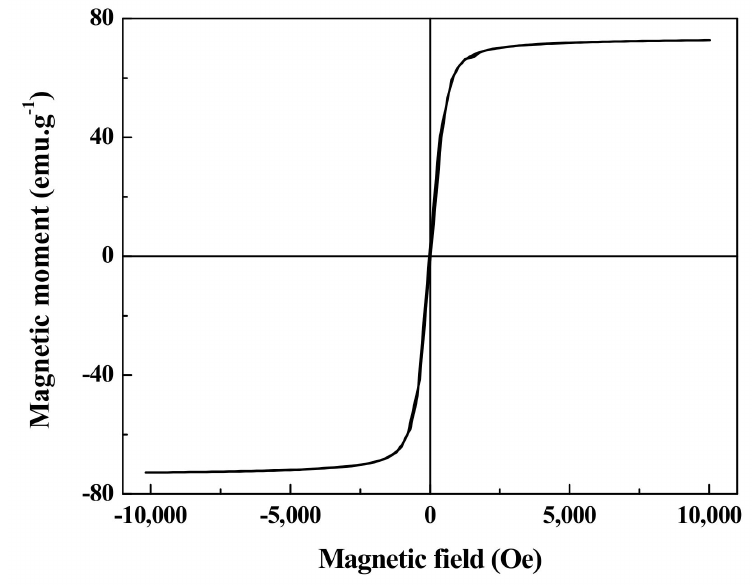
Figure 5. The magnetic hysteresis loops of the carbon-supported metal